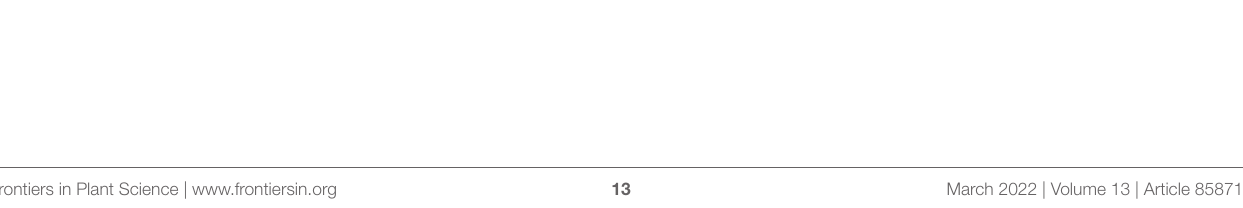
Frontiers in Plant Science |